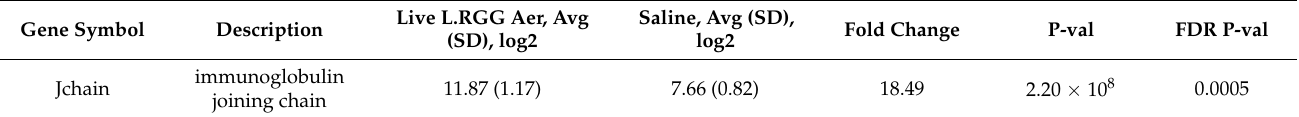
Table 2. Effect of live or dead L.RGG aerosol treatment on transcriptomic profile of the lung. Genes differentially expressed in comprehensive gene expression profiles comparing RNA extracted from live L.RGG -treated lungs versus saline-treated lungs. Gene expression average per group was cal- culated using one-step Tukey’s bi-weight algorithm, reported as binary logarithm (log2). The fold- change can be calculated as two power of the absolute difference between group averages. A negative fold-change indicates a greater expression in the control group. Further details on the calculations are available on pages 11–12 of the Affymetrix Statistical Algorithms Description Doc- ument, http://tools.thermofisher.com/content/sfs/brochures/sadd_whitepaper.pdf (accessed on 15 June 2022) (FDR p -value < 0.05) (8/9 samples/group). Abbreviations: Avg, average; SD, standard deviation; FDR, false discovery